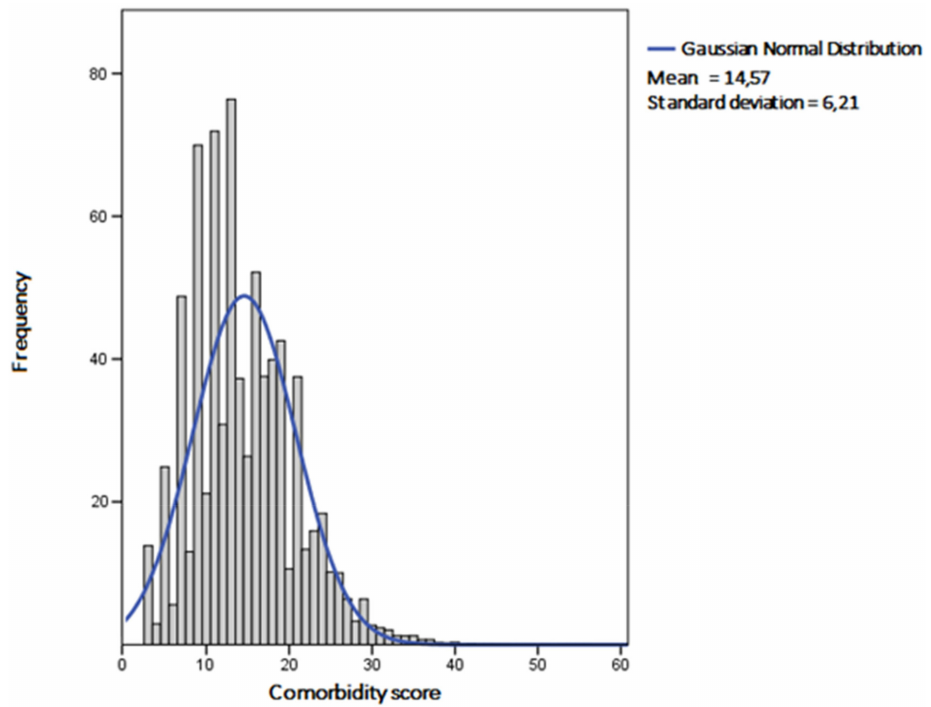
Figure 1. Distribution of the comorbidity score values in the population investigated.